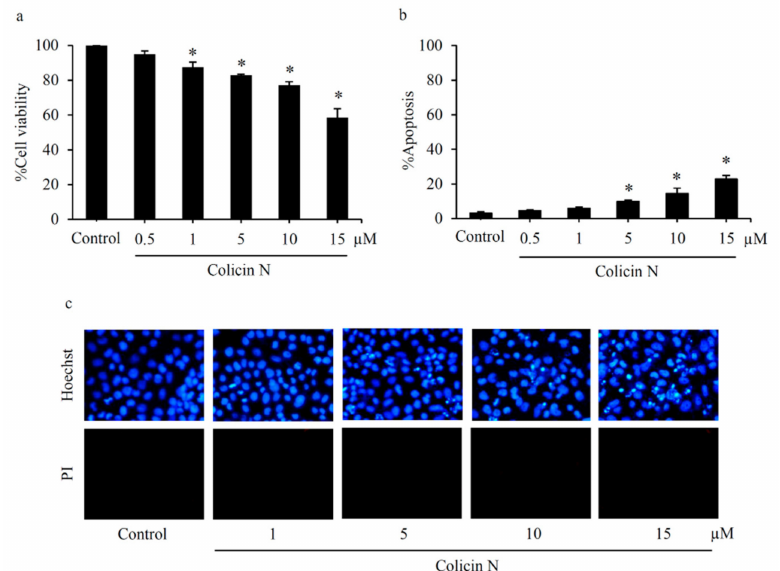
Figure 2. Apoptosis-inducing e ff ect of colicin N in human lung cancer cells ( a ) Reduction in cell viability detected by MTT assay of lung cancer H460 cells was observed after treatment with colicin N (1–15 µ M) for 24 h. ( b ) Significantly concentration-dependent increase in apoptosis occurred after colicin N treatment. ( c ) Co-staining with Hoechst33342 and propidium iodide (PI) reveals blue fluorescence of apoptosis in H460 cells treated with 5–15 µ M of colicin N for 24 h. Meanwhile, there was no noticeable necrosis presenting with red fluorescence. Values are means of the independent triplicate experiments ± SD. * p ≤ 0.05 versus non-treated